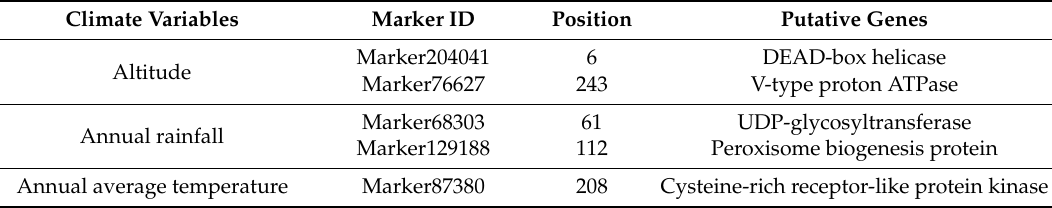
Table 8. Identification of putative candidate genes of the associated SNP